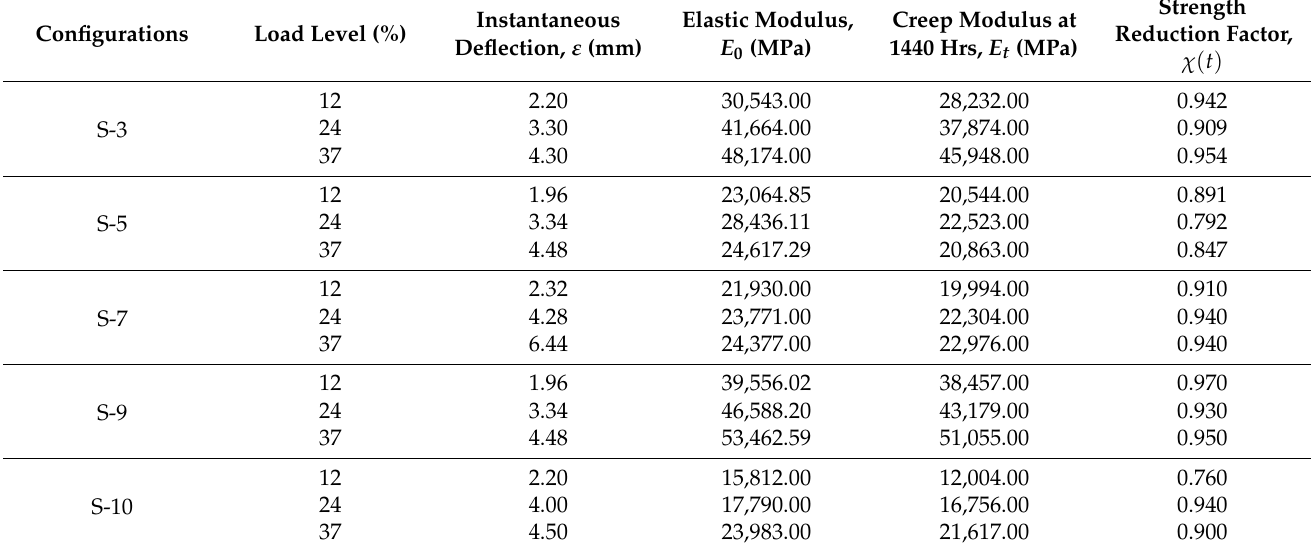
Table 6. Flexural creep data based on Findley’s power law